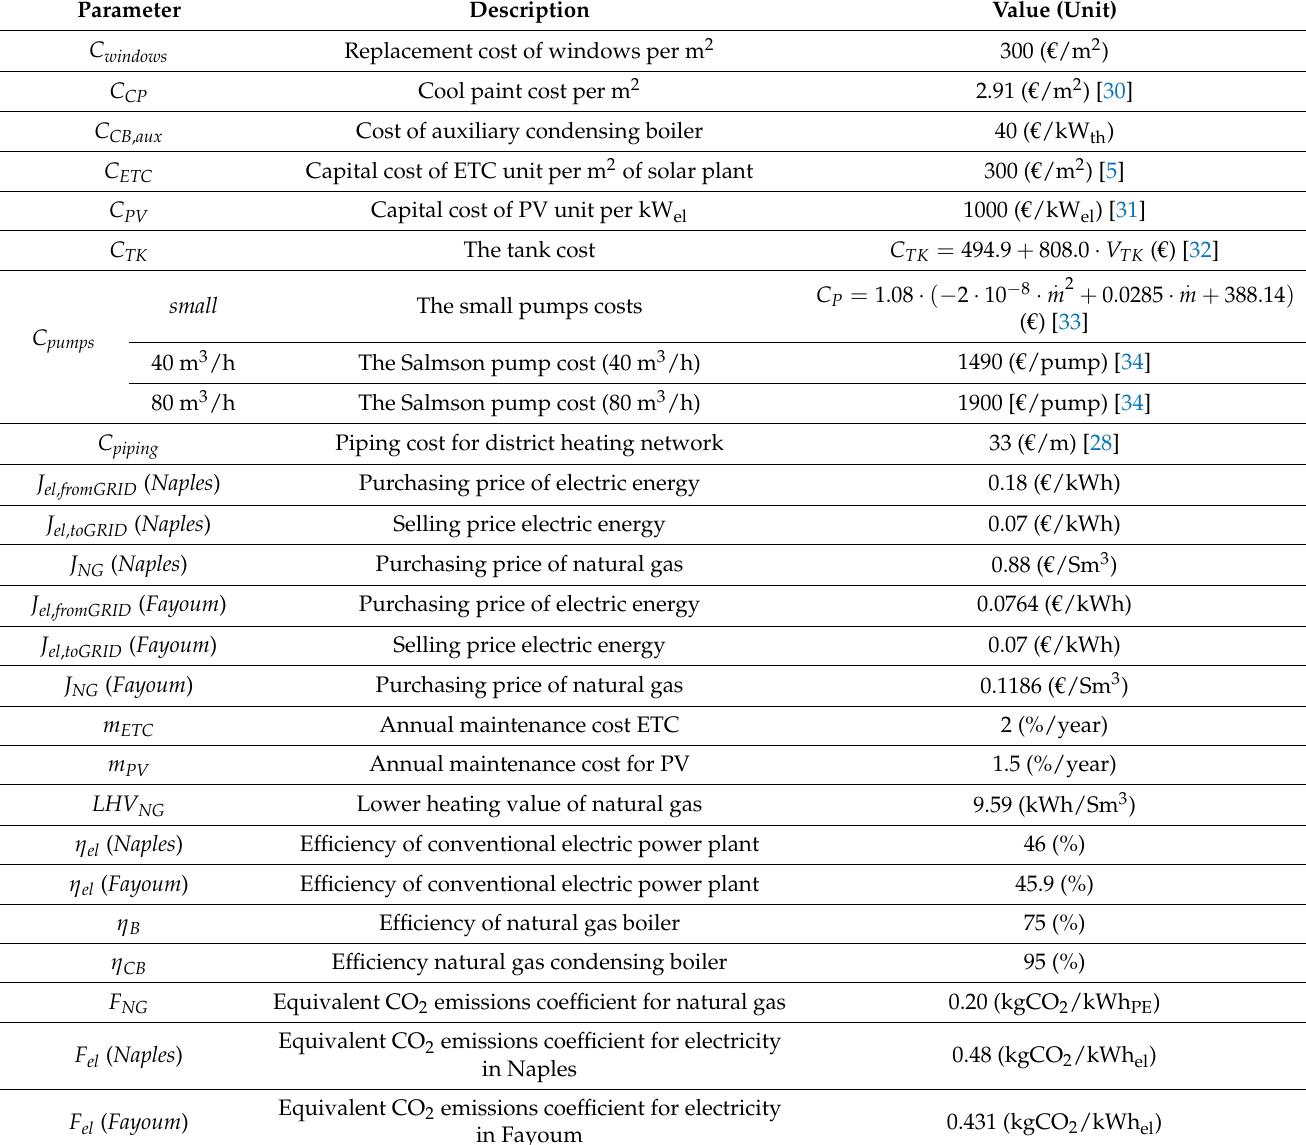
Table 2. Thermo-economic and environmental data.